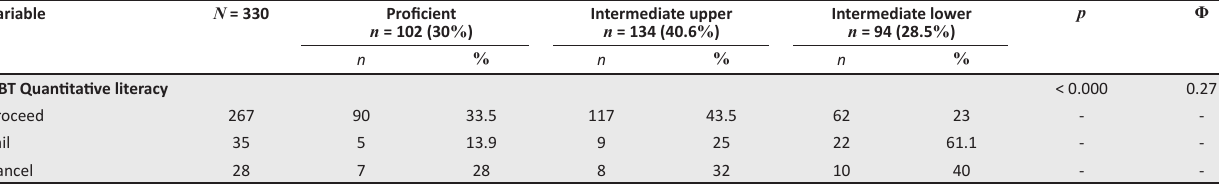
TABLE 6c: Associations between National Benchmark Test domains and first year Grade Point Average categories.